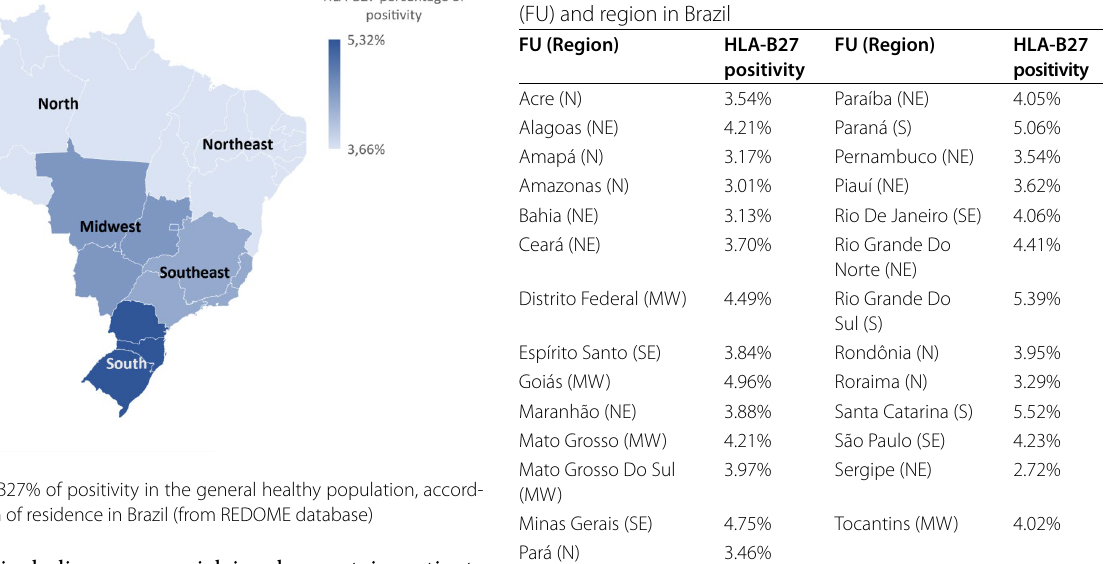
Fig. 3 HLA-B27% of positivity in the general healthy population, specified by region and race in Brazil (from the REDOME Table 2 HLA-B27% of positivity, according to each federal unit